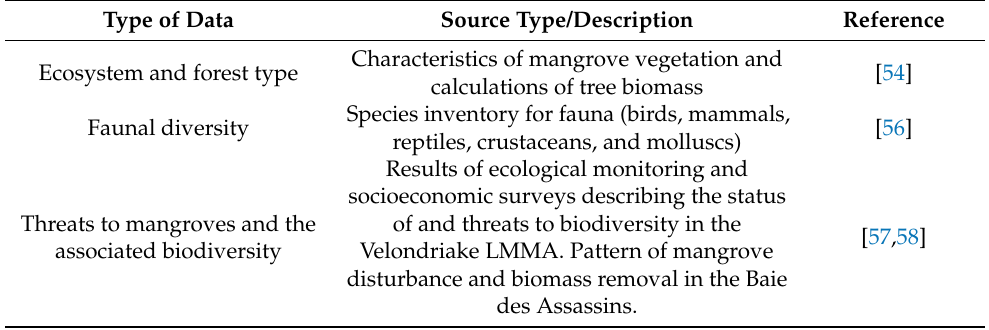
Table 2. Literature used to collate mangrove ecological information for the Baie des